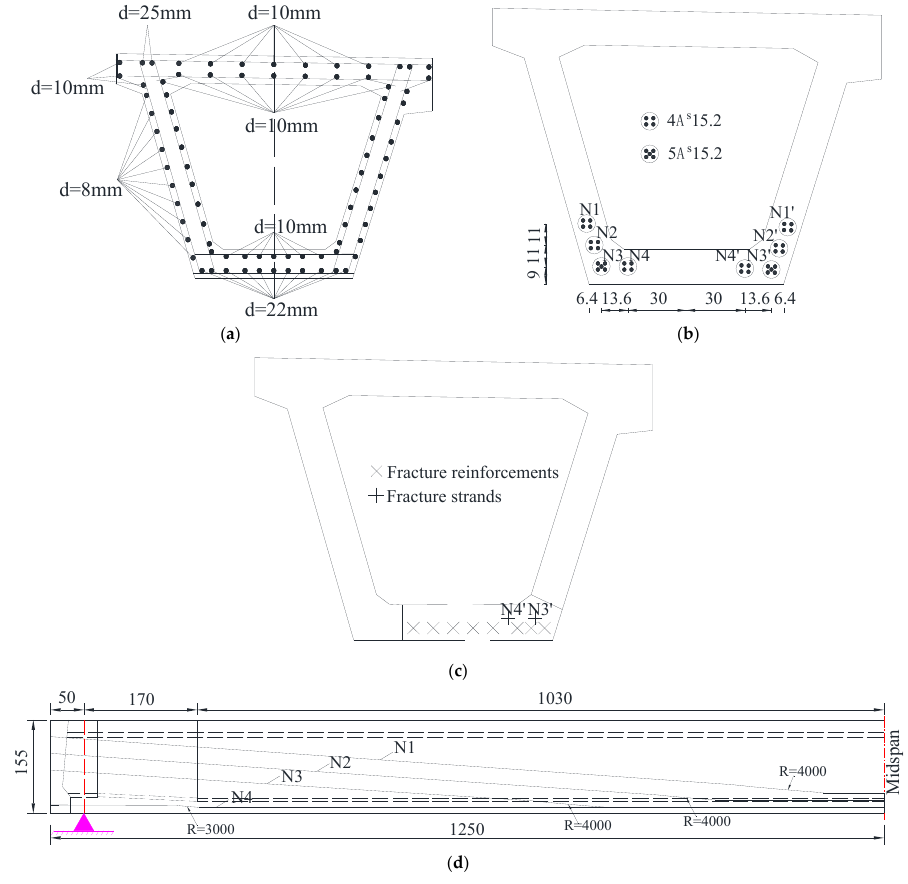
Figure 5. Reinforcements and strands arrangement in the girder (Unit: cm). ( a ) Steel bars in the undamaged beam (B-B); ( b ) Prestressed strands in the undamaged beam (B-B); ( c ) Steel bar condition at the damaged region of box girder #2 (C-C); ( d ) Strand arrangement. Table 1. Material parameters.